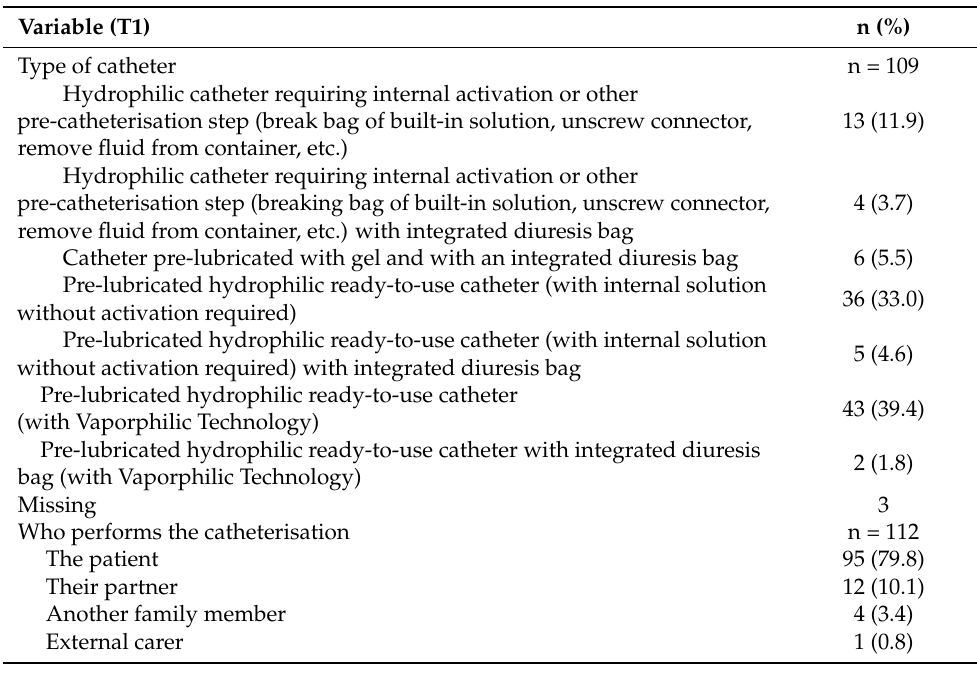
Table 6. Characteristics of the catheter used and its use. Second